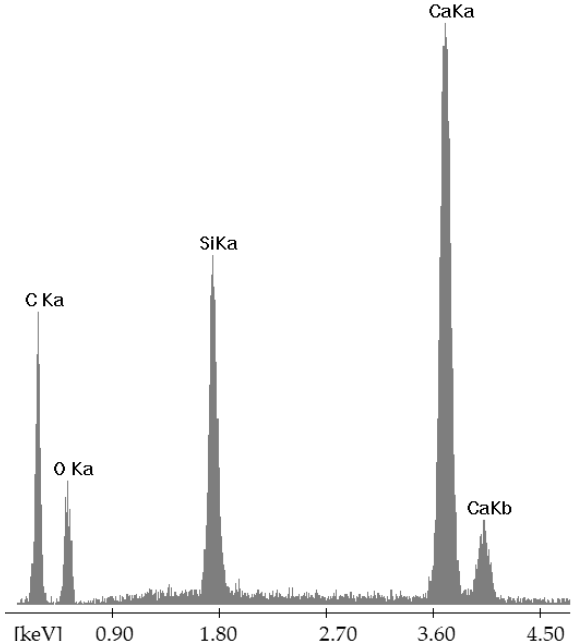
Figure 15. Energy-dispersive spectrometry (EDS) spectrum for traditional sand-lime bricks (containing quartz sand): Point 1.